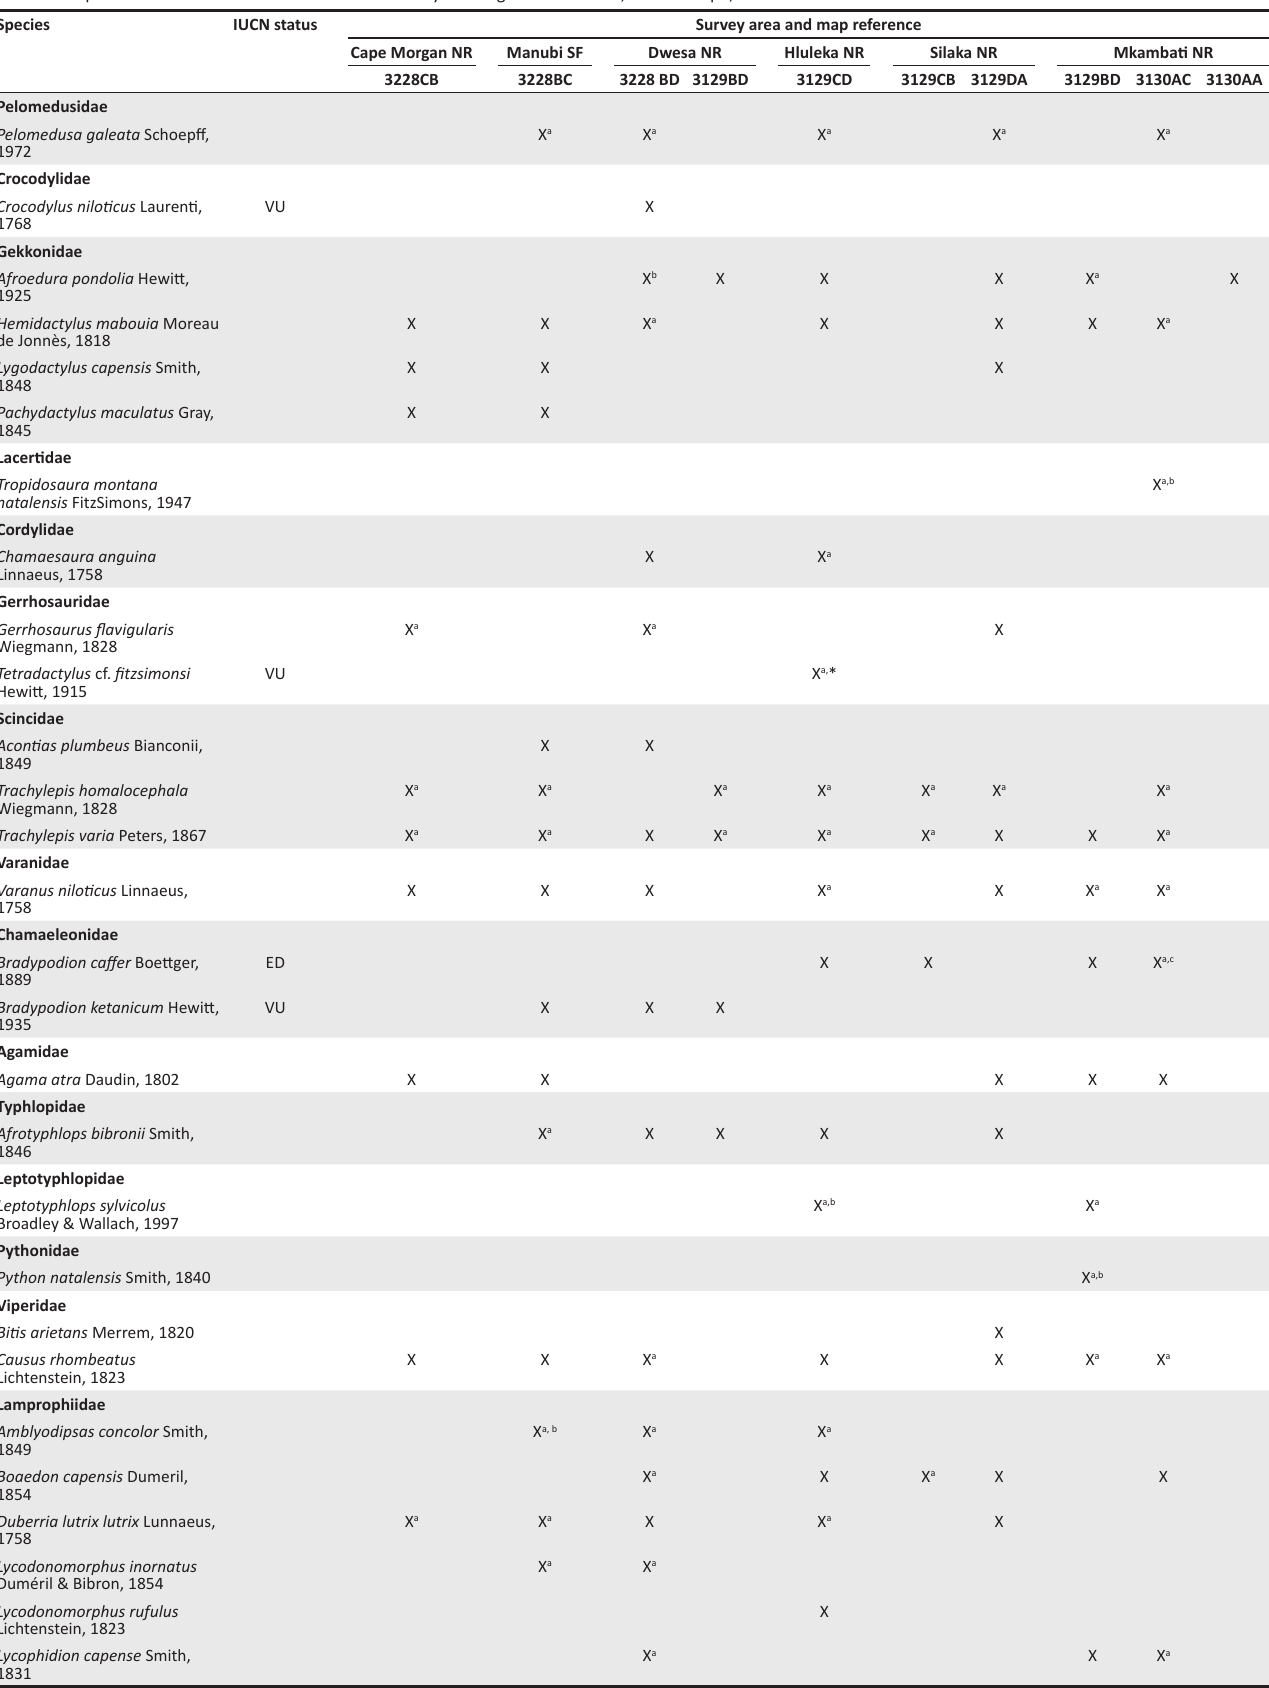
TABLE 2: Reptile checklist for six conservation areas surveyed along the Wild Coast, Eastern Cape, South Africa.